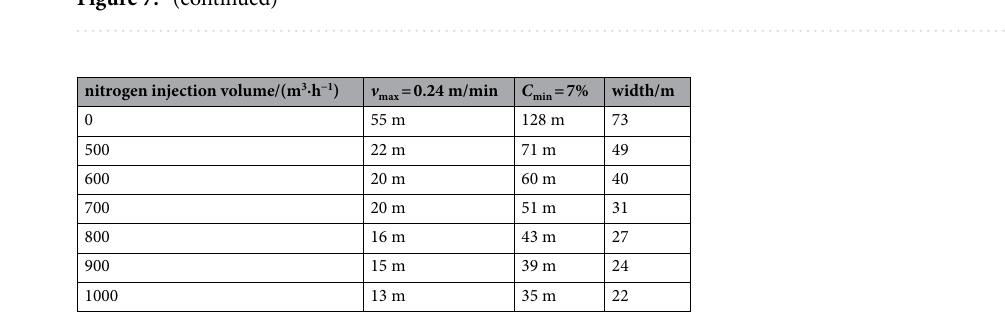
Table 2. Distribution of spontaneous combustion zone in goaf with different nitrogen injection volume.